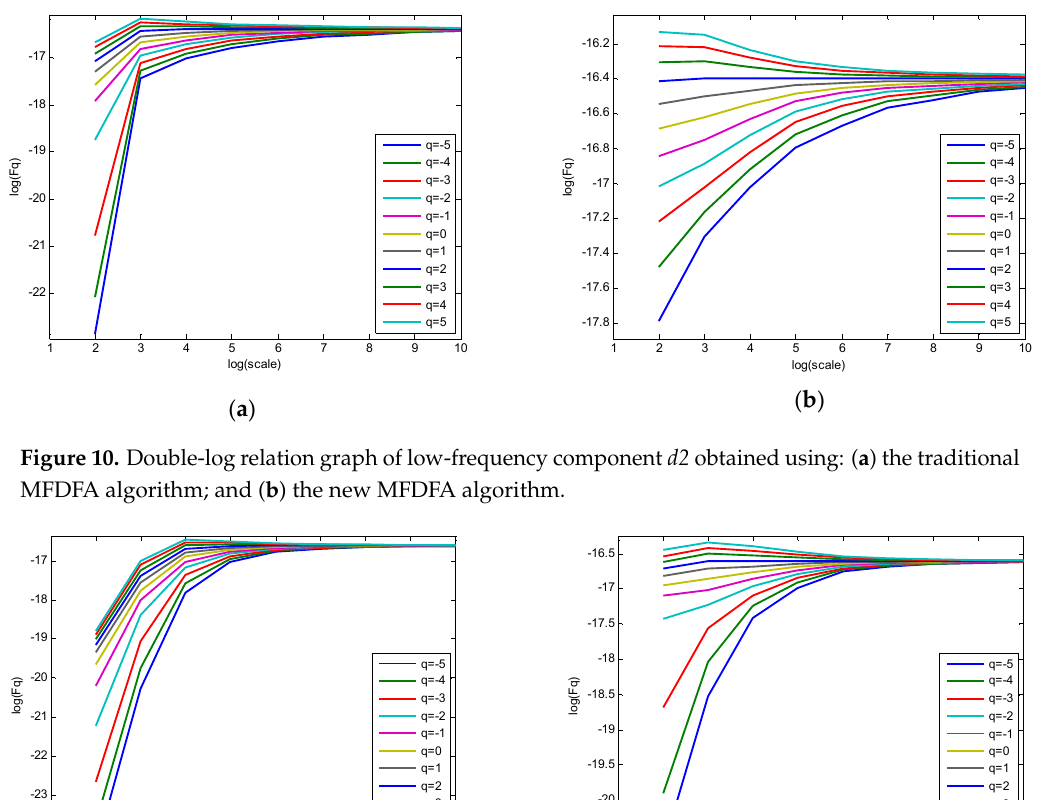
Table 2. ∆𝛼 , 𝛼 (cid:2868) and 𝛼 (cid:3040)(cid:3036)(cid:3041) values of the harmonic component computed analytically through traditional MFDFA and new MFDFA.